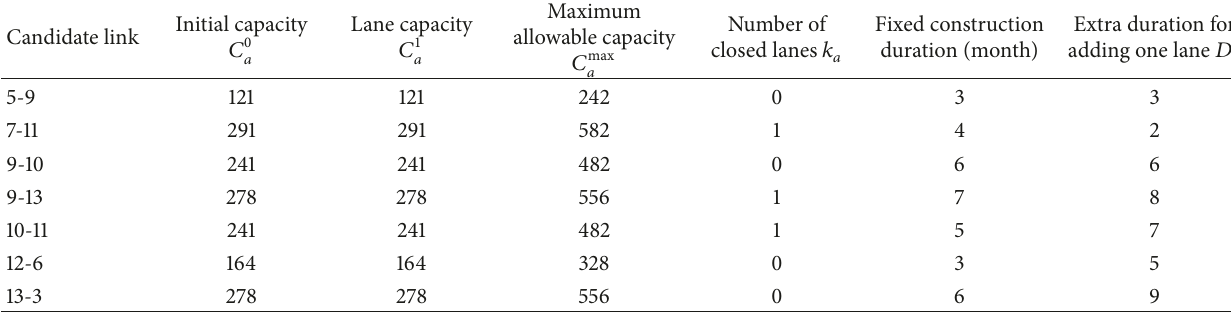
Table 2: Parameters for candidate projects in the Nguyen-Dupuis network.